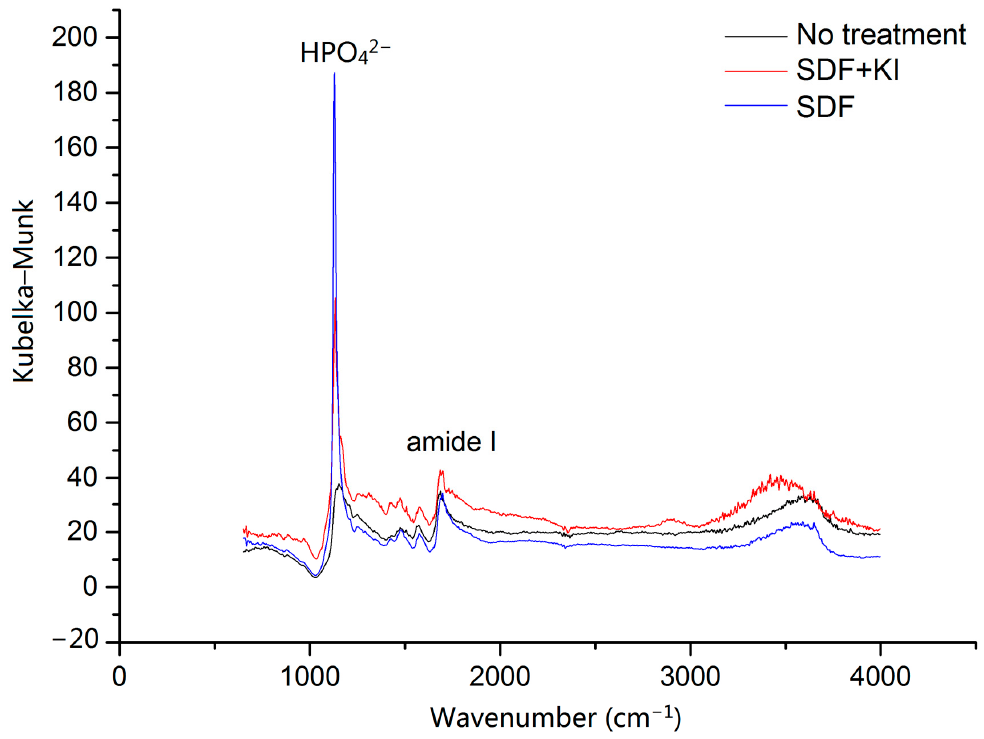
Figure 3. Fourier transform infrared (FTIR) spectra of dentine at the material-root junction. SDF + KI: Group 1, the cavity was treated with silver diamine fluoride and potassium iodide; SDF: Group 2, the cavity was treated with silver diamine fluoride as positive control; No treatment: Group 3, negative control. The strongest peak of HPO 42 − was found in Group 2, followed by Group 1 and 3.